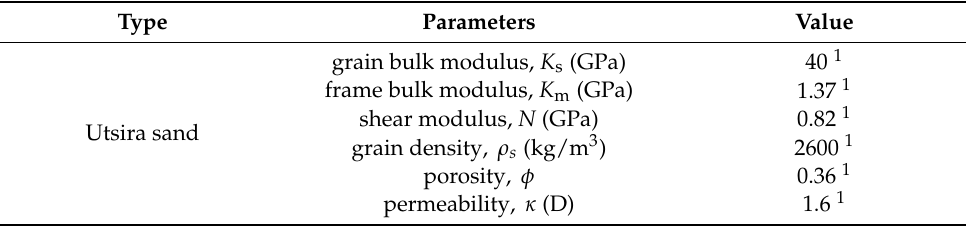
Table 1. Physical parameters of unsaturated porous